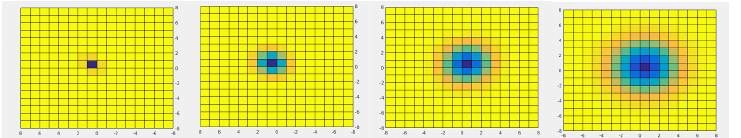
Figure 6. Images of simulated traces in four sizes, from the left: 1, 2, 3, and 4 px.